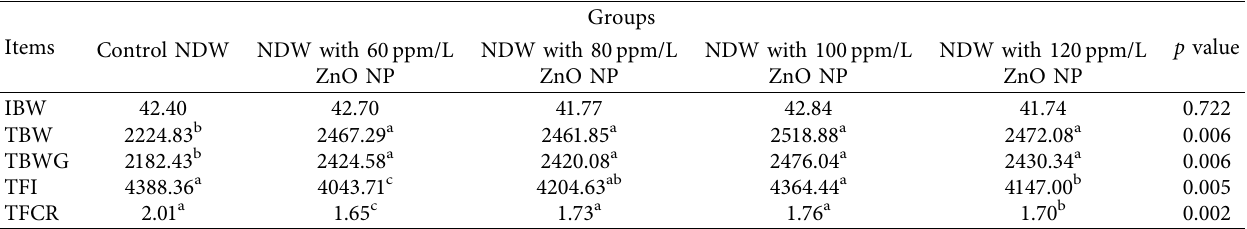
Table 2: Efect of zinc oxide nanoparticles (ZnO NPs) on broiler production at 42 days of age. Items